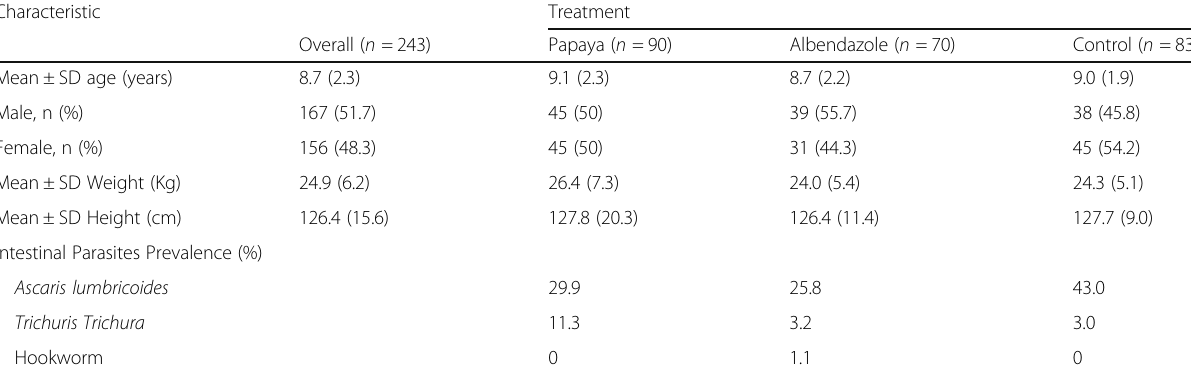
Table 2 Baseline characteristics of children who completed the study by intervention group Characteristic